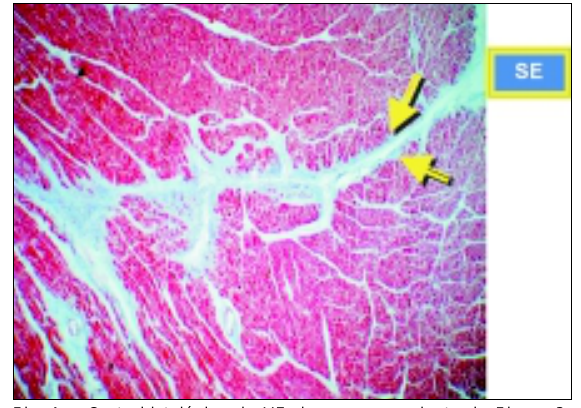
Fig. 4 - Corte histológico de VE do mesmo paciente da Figura 3, mostrando trave de fibrose miocárdica intersticial, perpendi- cular ao epicárdio (setas) que se estende a partir da região subepicárdica (SE) em direção ao endocárdio (tricrômico de Masson, aumento original X